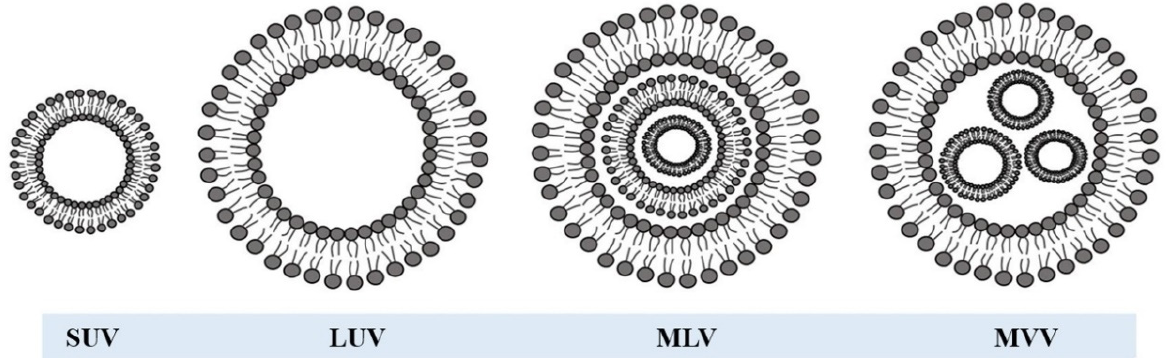
Figure 2. Liposomal classification is based on lamellarity and size. Reprinted with permission from [2]. Copyright (2021), Elsevier. SUV: small unilamellar vesicle; LUV: large unilamellar vesicle; MLV: multilamellar vesicle; MVV: multivesicular vesicle.